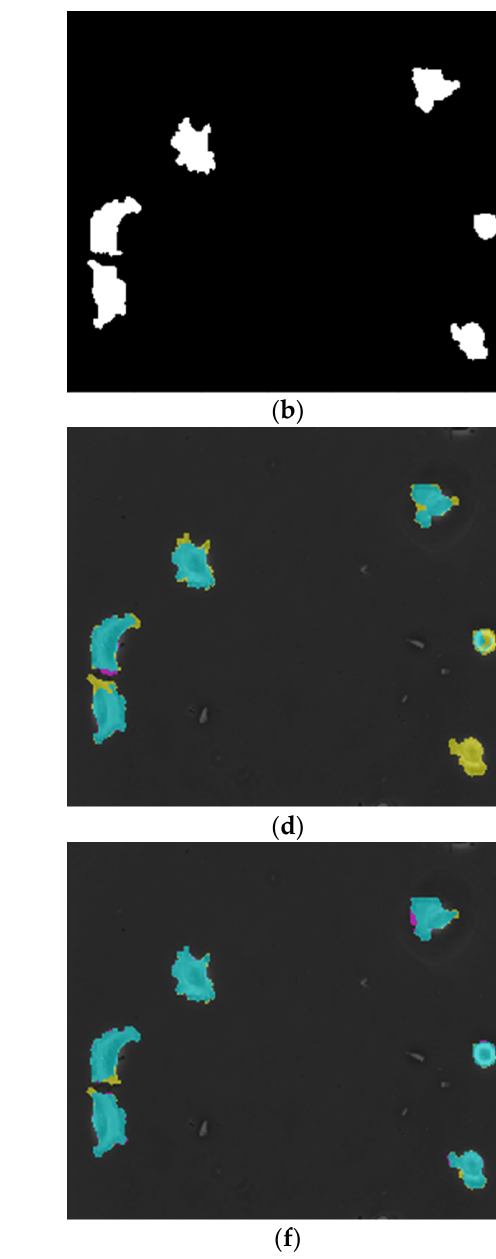
Table 5. Comparative results between U ‐ Net with depth 4, AID ‐ U ‐ Net (3, 1) and AID ‐ U ‐ Net (2, 2) applied to microscopic image segmentation.